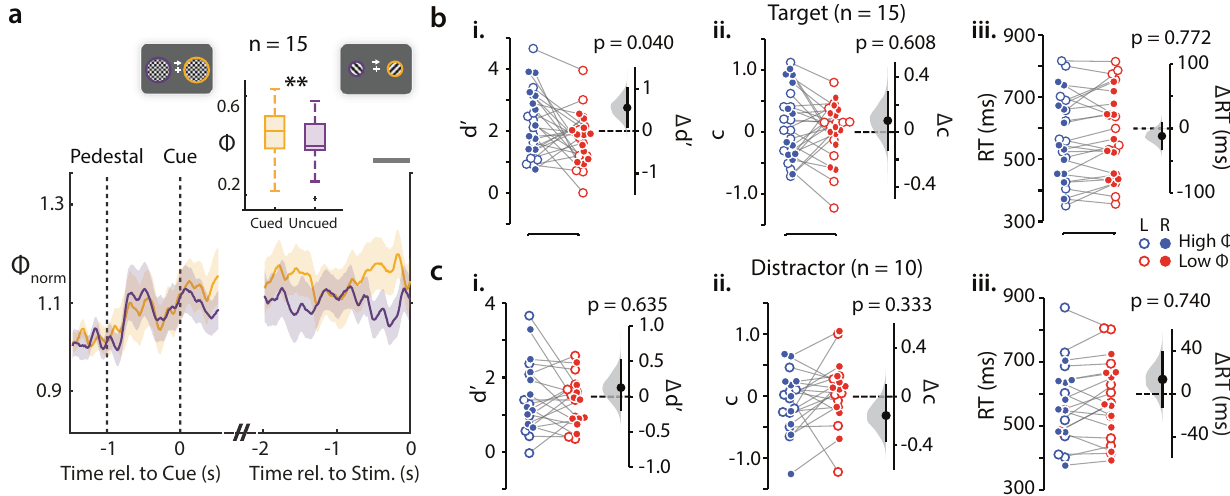
Fig. 2 Momentary SSVEP power fl uctuations predict target discrimination accuracy (d ′ ). a Time evolution of Φ norm (fractional change in Φ over baseline) for cued (yellow) and uncued (purple) trials, pooled across all subjects ( n = 15) and frequencies, time locked to cue onset (left half) or to grating stimulus presentation (right half) on non-triggered trials (see text for details). Shaded region: s.e.m. across subjects. (Inset) Mean Φ for cued (yellow) and uncued (purple) trials in the interval − 500 ms – 0 ms before stimulus onset (dark gray horizontal bar). Central mark: median, edges: 25th and 75th percentiles, the whiskers: most extreme points, + : outliers. ** p < 0.01. b (i) Discrimination accuracy (d ′ ) for high- Φ (blue) and low- Φ (red) trials for the target-side triggered trials, in which grating presentation was triggered based on the cued (target) side SSVEP power index ( Φ ) for all ( n = 15) subjects. Open and fi lled circles: Trials triggered based on left- and right-hemi fi eld Φ values, respectively. Black dot and error bar: Mean effect size and 95% con fi dence interval, respectively, for the difference between d ′ across high- Φ and low- Φ trials. Gray histogram: bootstrap sampling distribution for effect size. Dashed horizontal line: Datum indicating zero effect size. (ii) Same as panel i, but for choice criterion (c). (iii) Same as panel i, but for reaction times. c Same as in ( b ), but comparing discrimination accuracy (d ′ , i), choice criterion (c, ii), and reaction time (iii) across high- Φ and low- Φ trials for the distractor-side triggered trials, in which grating presentation was triggered based on the uncued (distractor) side SSVEP power index ( Φ ). Other conventions are the same as in panel b